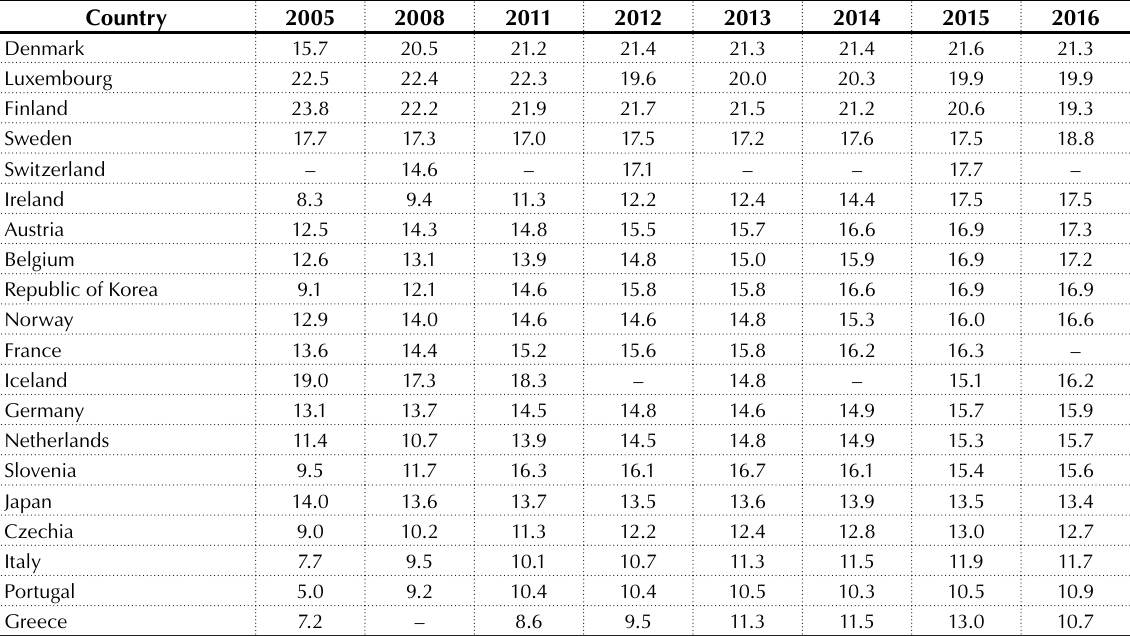
Table 7. TOP-20 countries: total R&D personnel per thousand total employment (in full-time equivalents),